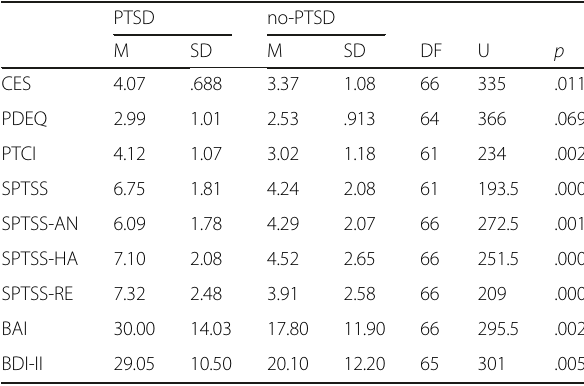
Table 3 Spearman correlations in the no-PTSD